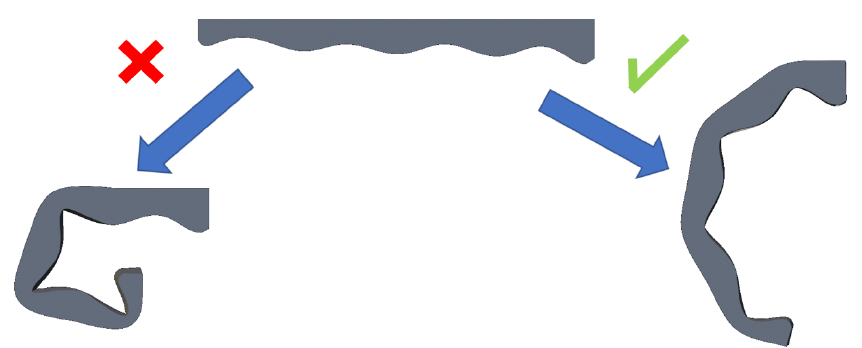
Figure 5. Example of the bad fold of soft limb and good fold when changing j i